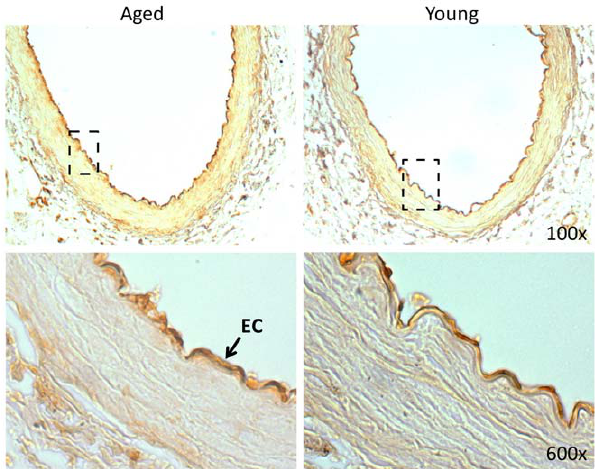
Figure 4. Myl9 immunostaining of old (22 months) and young (3 months) non-injured rat iliac arteries. Shown are representative images of young and old healthy iliac arteries immunostained for Myl9. Results confirm over-expression of Myl9 in the older group and point to concentration of Myl9 expression in the endothelial layer of the iliac arteries.